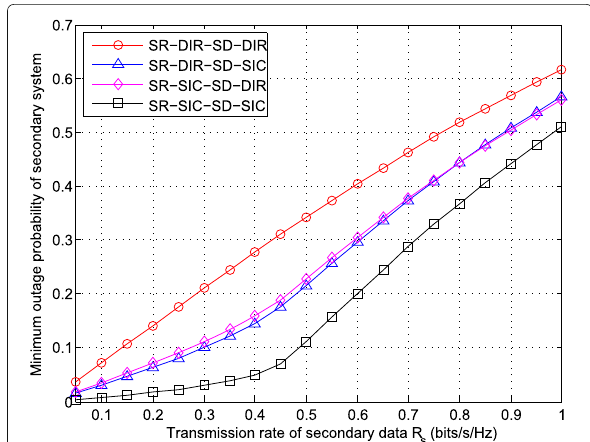
Fig. 15 Minimum outage probability of secondary system vs the transmission rate R s